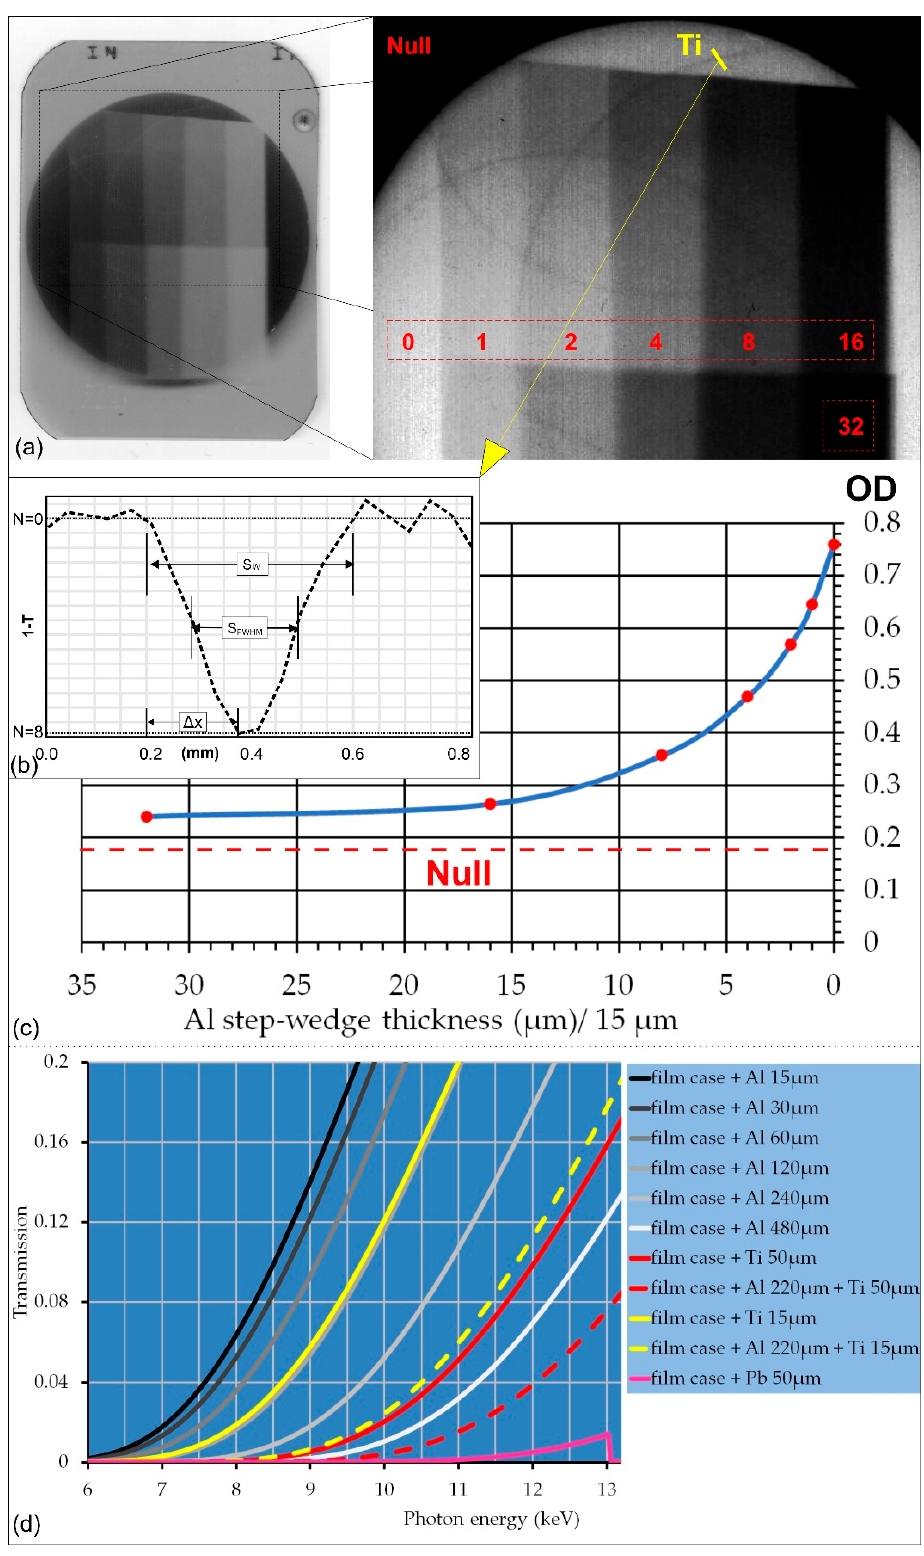
Figure 8. ( a ) Time-integrated monochrome-negative radiograph (left) and its inverted X-ray-magnified area of interest (right). ( b ) Transverse lineout that indicates the shadow of the projected wire on the film. ( c ) OD in relation to the N numbers. ( d ) Total transmission curves, including the transmission of the film package.